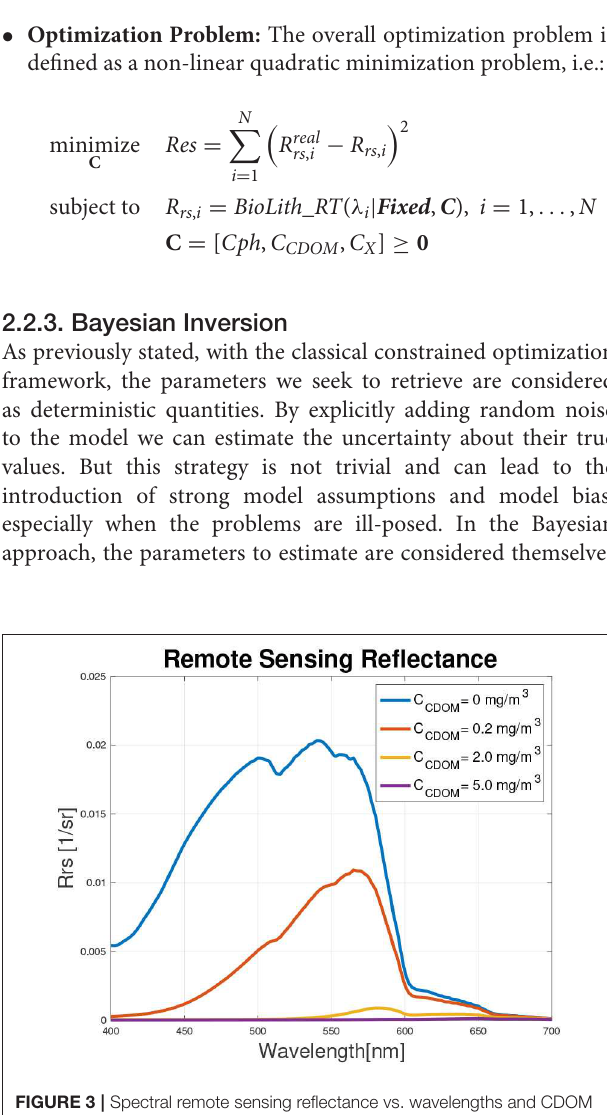
FIGURE 3 | Spectral remote sensing reflectance vs. wavelengths and CDOM concentration.